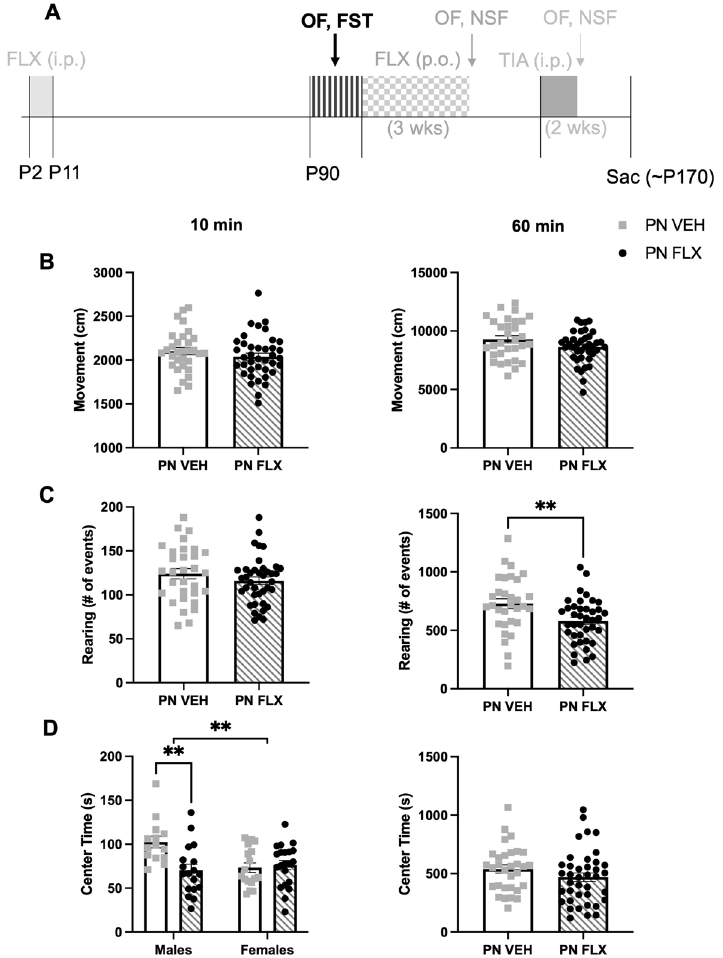
Figure 1. Decreased novelty-induced exploration and increased avoidant behavior in the first 10 and full 60 min of open field following chronic postnatal fluoxetine exposure in C57 mice. ( A ) Timeline of experiment: The window for developmental administration of fluoxetine and future phases of the experiment are illustrated in faded light grey; Black and grey stripes indicate when baseline adult phenotyping using the OF and FST occurred. ( B ) Ambulatory movements in the first 10 min of the open field (left panel, unpaired, two-tailed, t-test, p = 0.2846). Same for total 60 min (right panel, unpaired, two-tailed, t-test, p = 0.0712). ( C ) Rearing movements in the first 10 min (left, unpaired two-tailed, t-test, p = 0.2649). Same for total 60 min (right, unpaired, two-tailed, t-test, ** p = 0.0054). ( D ) Time spent in center in the first 10 min (left panel, two-way ANOVA, F(1, 66) = 8.374, ** p = 0.0052 for interaction of sex and treatment, F(1, 66) = 3.739, p = 0.0574 for main effect of sex, F(1, 66) = 5.812, * p = 0.0187 for main effect of treatment; Bonferroni post-hoc for males: ** p = 0.0012, n = 14 PNVEH, 18 PNFLX; for females: p > 0.99, n = 17 PNVEH, 21 PNFLX). Same for total 60 min (right panel, unpaired, two-tailed, t-test, p = 0.1813). Light gray squares represent PNVEH animals, n = 31. Black circles and grey stripes represent PNFLX animals, n = 39. Interaction effects from the 2-way ANOVA are represented as significance lines between males and females, and the Bonferroni post-hoc results are depicted as significance lines within the males. Bars represent mean. Error bars represent standard error. * p < 0.05, ** p < 0.01, *** p < 0.001, **** p <